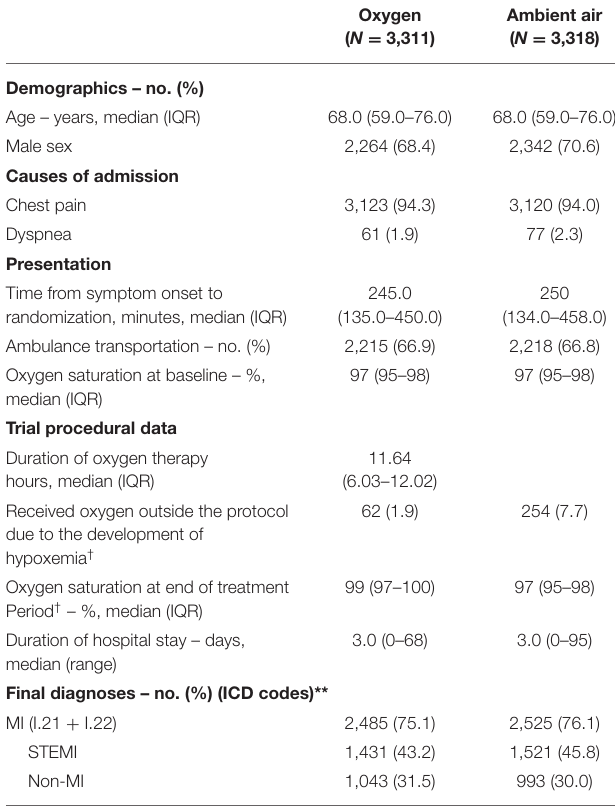
TABLE 1 | Patient baseline and trial specific characteristics in the DETO2X-AMI